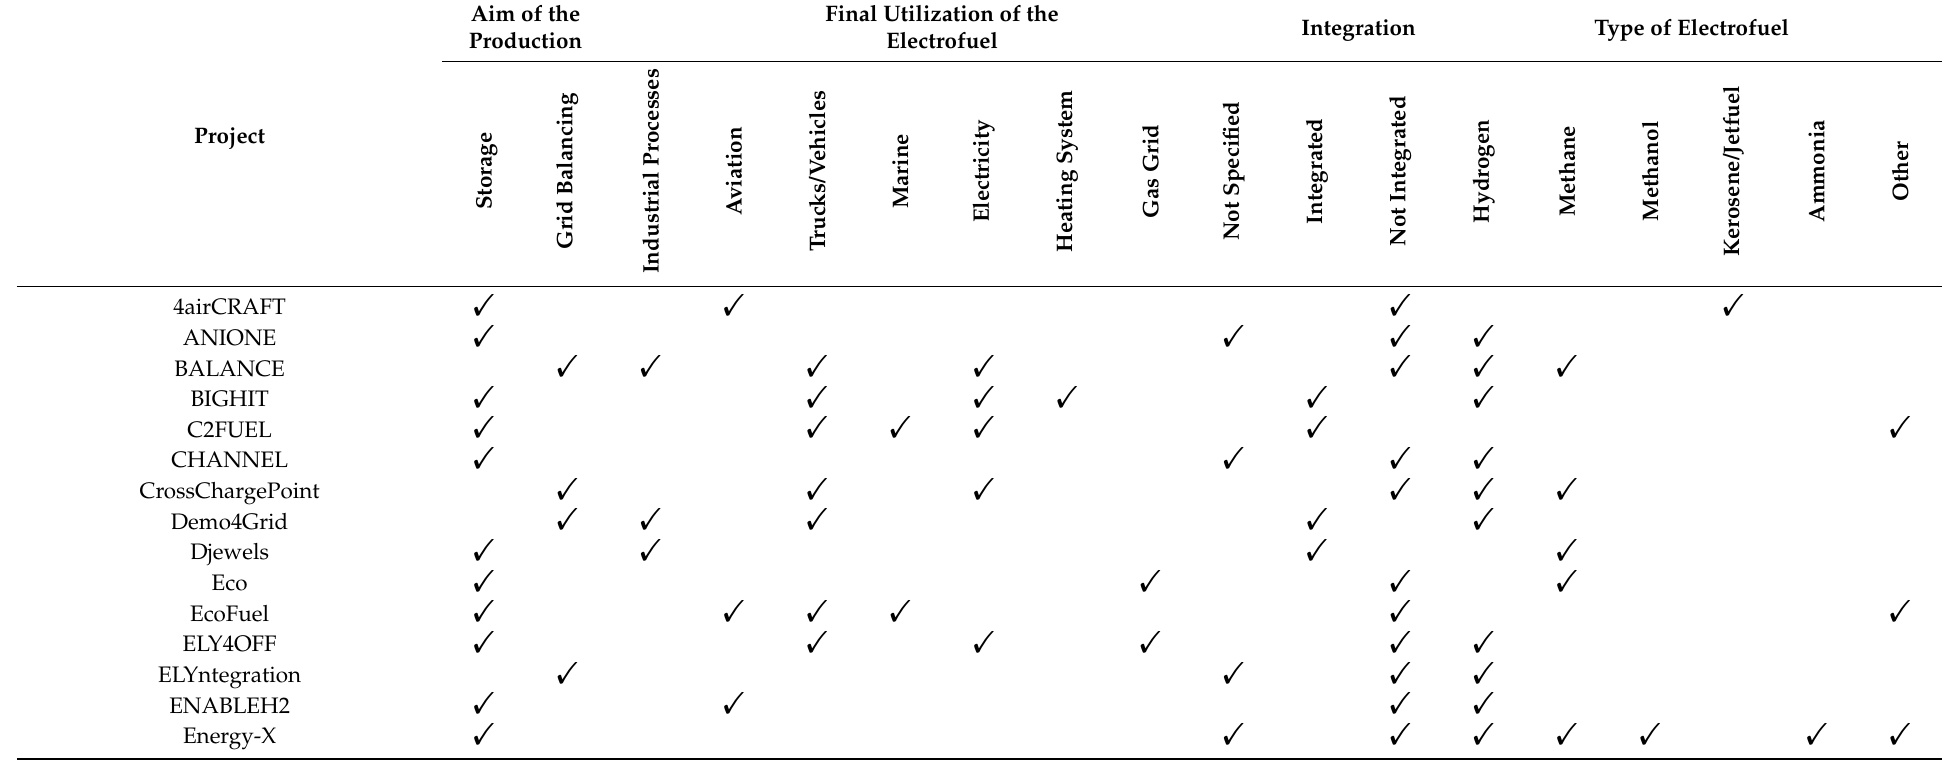
Integration Type of